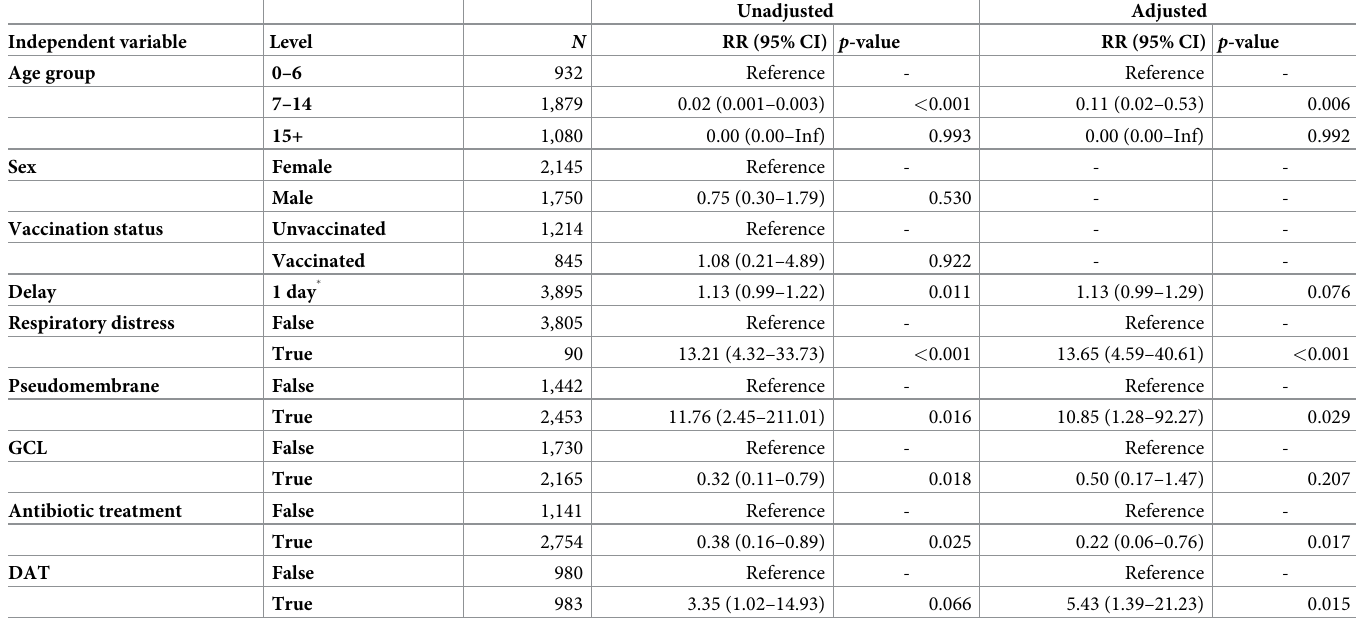
Table 3. Multivariable Poisson regression for predictors of fatality among for confirmed and probable diphtheria patients, Cox’s Bazar, Bangladesh, November 10, 2017 to November 10, 2019.